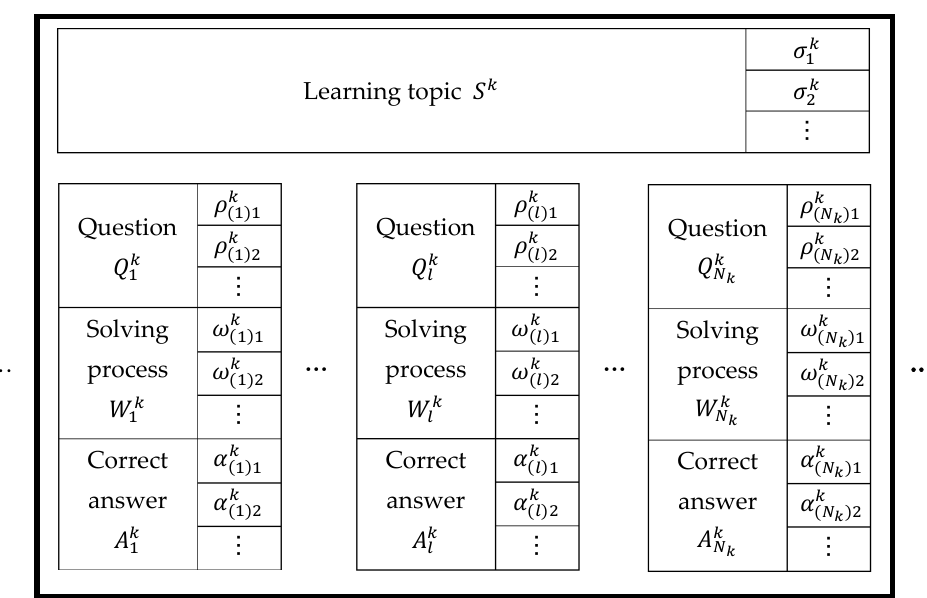
Figure 3. Composition of learning contents stored in e-learning systems.